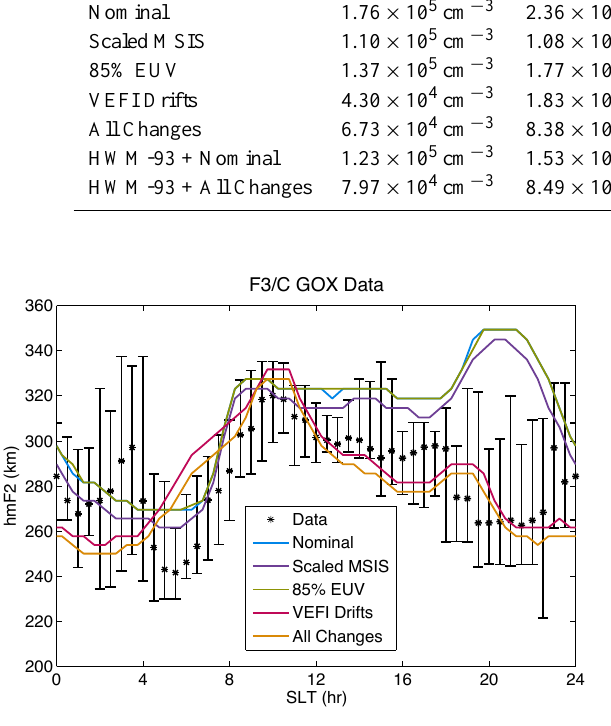
Fig. 8. The median hm F2 values derived from F3/C, with the ver- Fig. 9. The equatorial neutral winds at 300km and 240 ◦ E predicted tical bars representing the upper and lower quartiles. The modeled by HWM-07 (solid) and HWM-93 h m F 2 values derived from F3/C, with the vertical bars representing the upper and lower Fig. 8. The median results are the same as Fig. 4. Fig. 9. The equatorial neutral winds at 300 km and 240 ◦ E predicted by HWM-07 (solid) and HWM-93 quartiles. The modeled results are the same as Figure 4. (dashed).